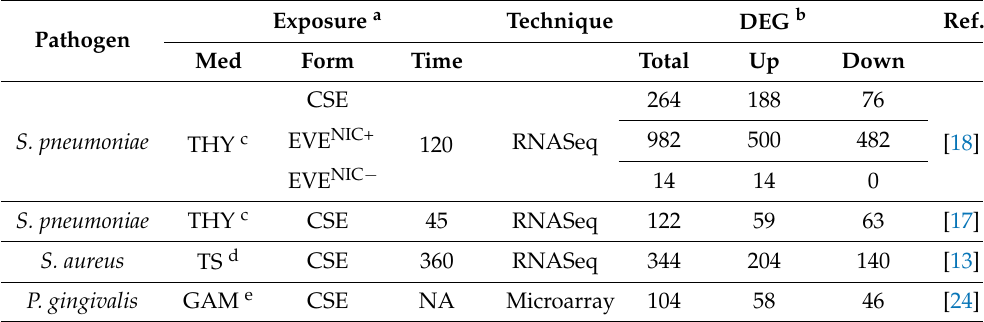
Table 2. The effects of CS/EV in vitro exposure on bacterial transcriptome.